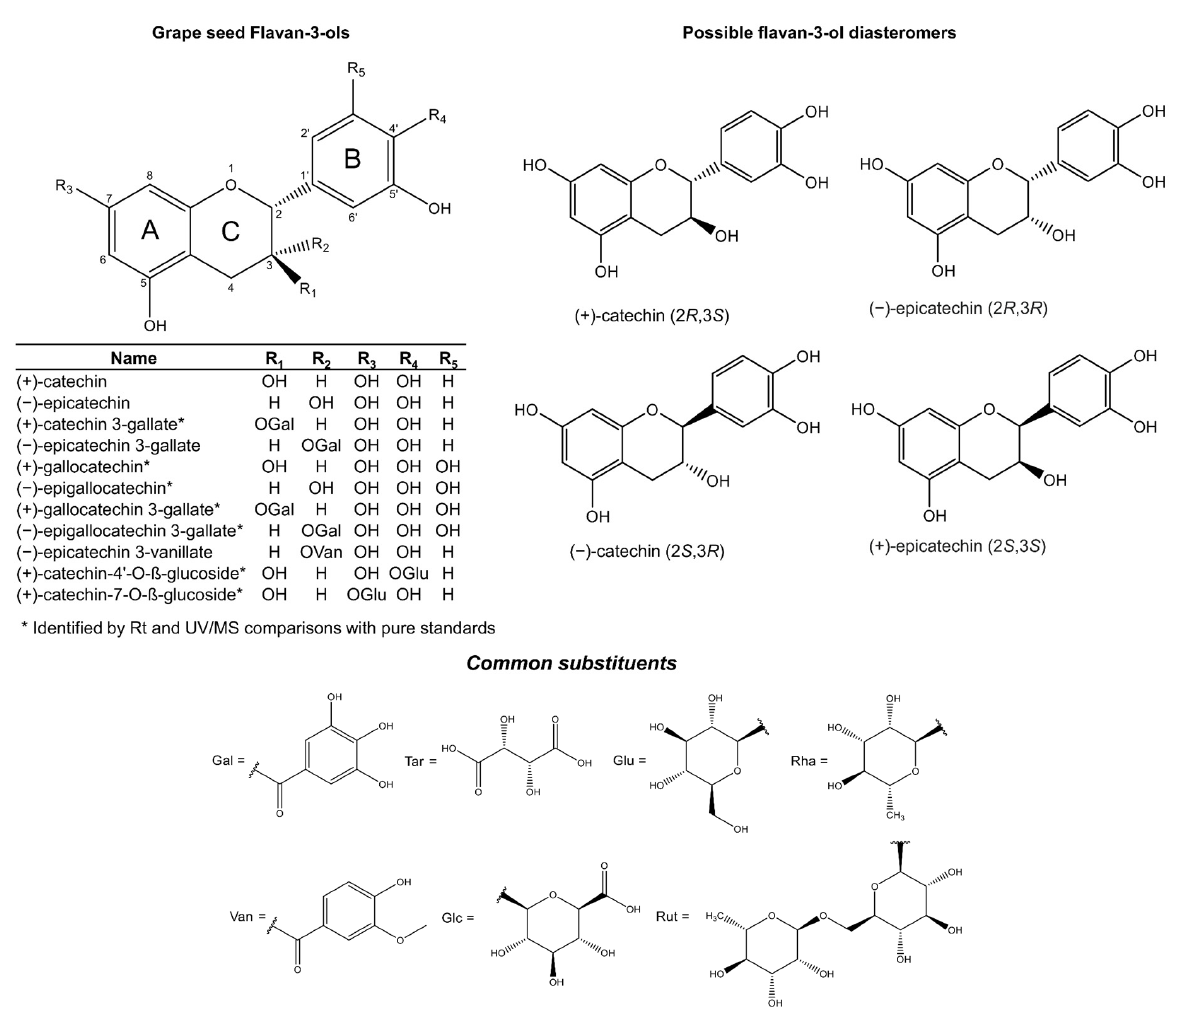
Figure 1. Flavan-3-ol monomers reported in grape seed (upper left) including possible flavan-3-ol epimers and enantiomers (upper right). Common O- or COO-linked substituents of flavan-3-ols and other phenols are included in the lower panel.